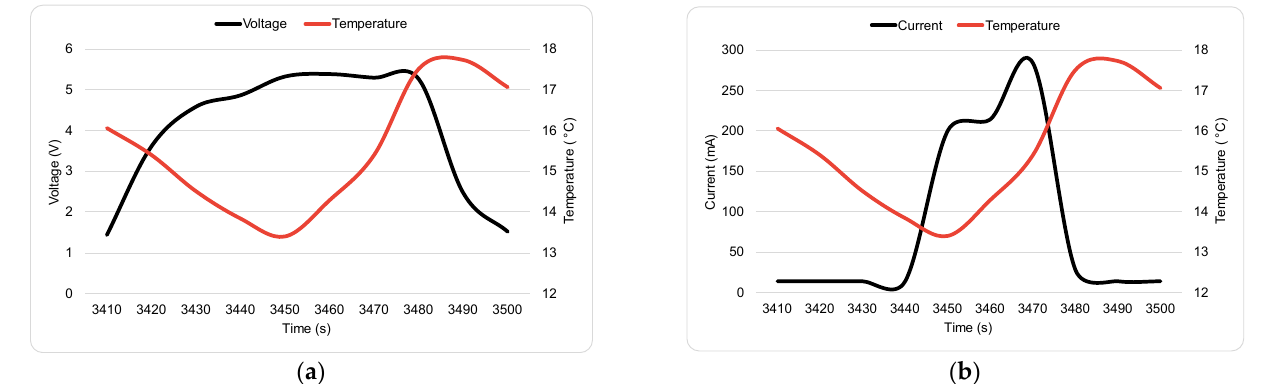
Figure 5. +Y panel parameters correlation: ( a ) voltage vs. temperature, ( b ) current vs. temperature.